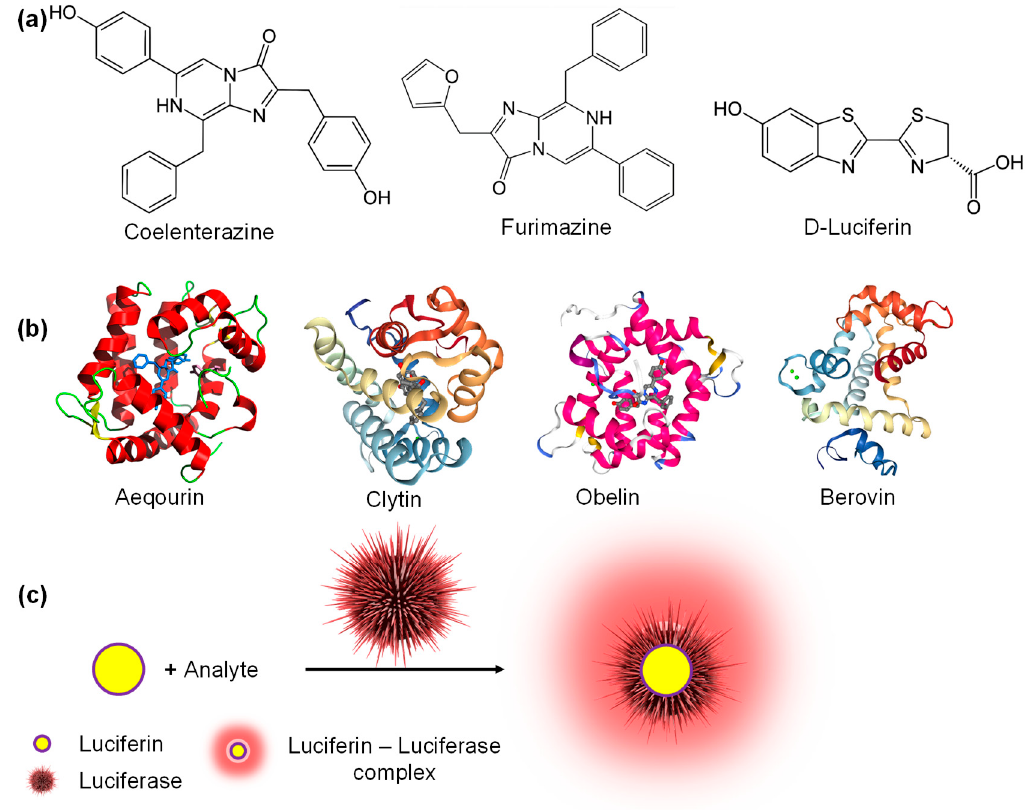
Figure 9. ( a ) Small molecules as luciferins; ( b ) Photoproteins; ( c ) Bioluminescence with a luciferin- luciferase assembly.